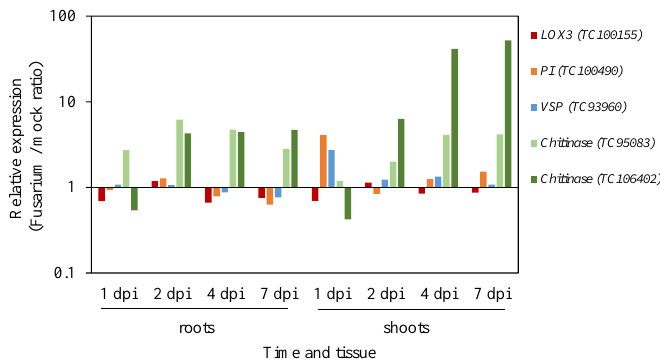
Figure 1. JA-inducible gene expression following F. oxysporum infection. M. truncatula A17 seedlings were inoculated with F. oxysporum ( Fom -5190a) and root and shoot tissues harvested separately at 1, 2, 4 and 7 days post inoculation (dpi). Gene expression values were determined relative to the internal control Beta-tubulin gene for each mock or Fusarium treated sample. Values shown are fold-inductions in Fusarium treated samples relative to mock treated samples at the same time-point from the average of eight pooled